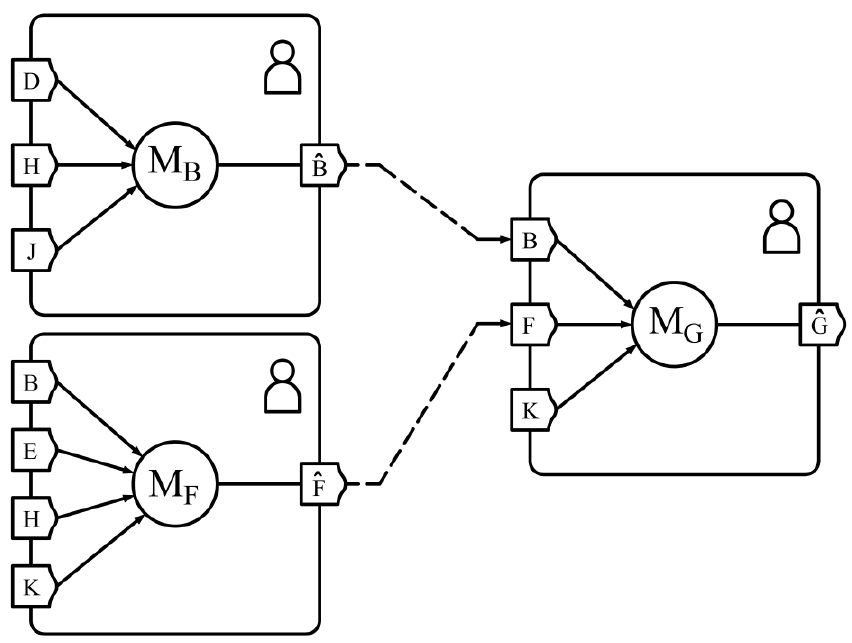
Figure 4. Interconnections of models for false alarm detection.